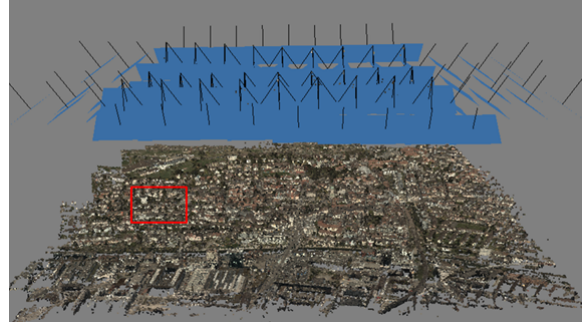
Fig.8.The result of tie points generated by Photoscan